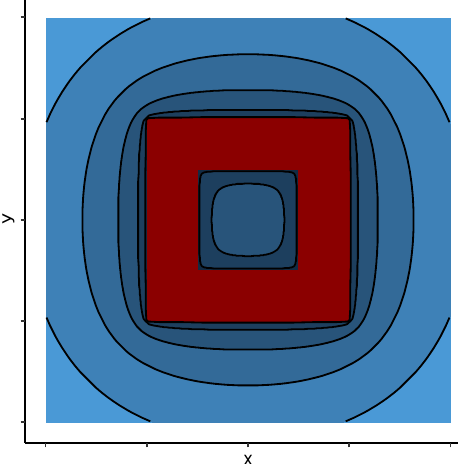
(cid:82) 1/ d ( x , s ) 2 d µ ( s ) for each S